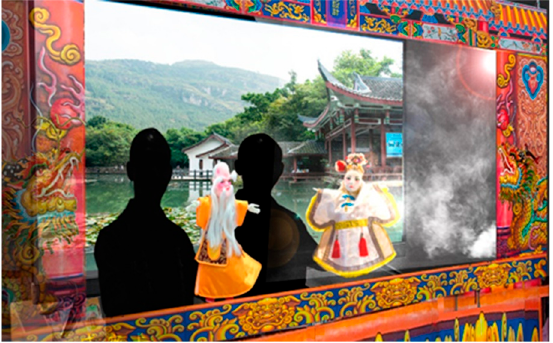
Figure 11. Two performers operating puppets on the simulated stage of the proposed